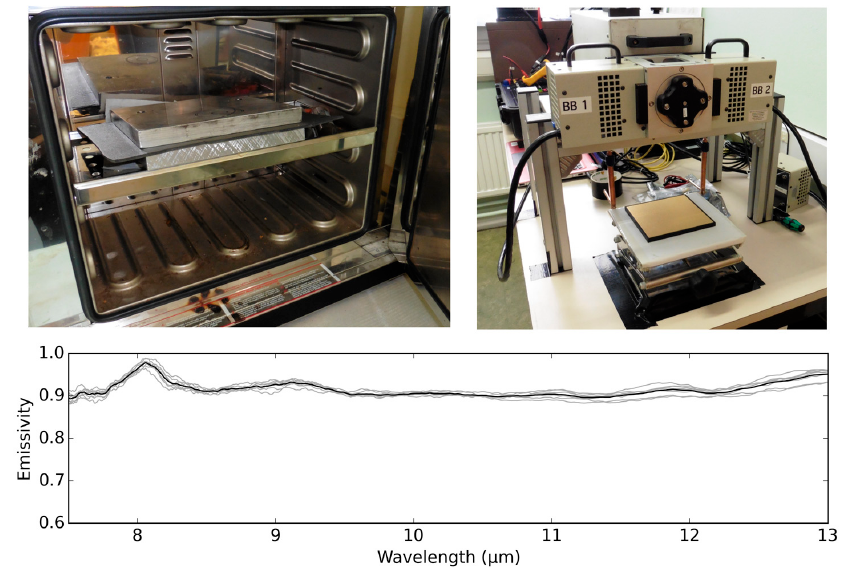
Figure 2. Emissivity retrieval procedure: heating up of the sample in a convection oven between two metal plates, measurements setup, and average absolute spectral emissivity (black) of the target retrieved from eight spectral measurements (grey).